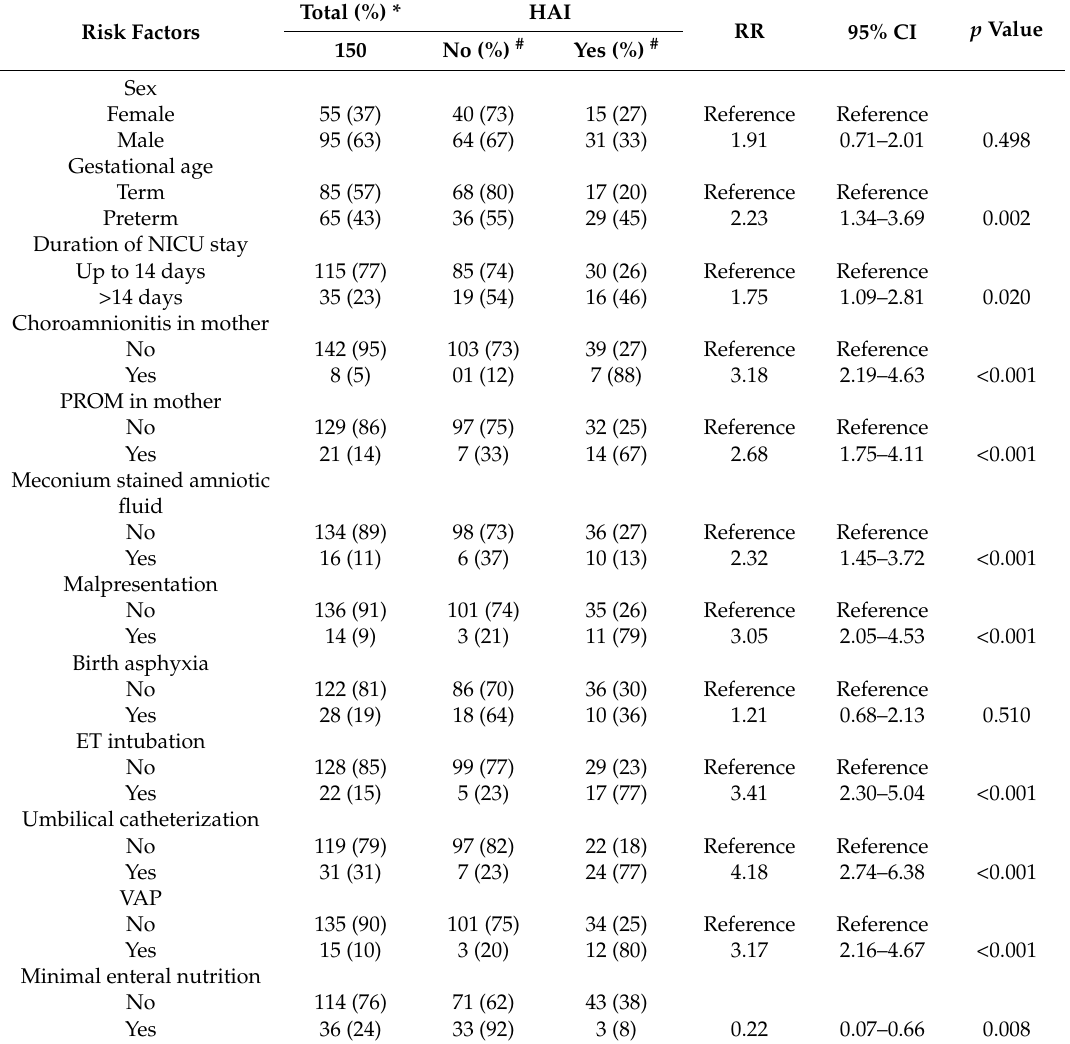
Table 1. Multivariate analysis of neonatal and maternal characteristics associated with laboratory-confirmed blood stream infections in a cohort of 150